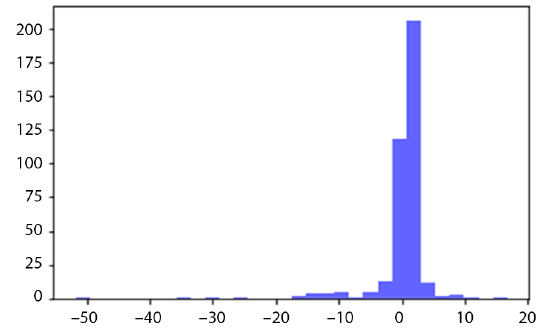
Figure 3. Histograms of values for FP index in years 2012–2018 (without 2011)